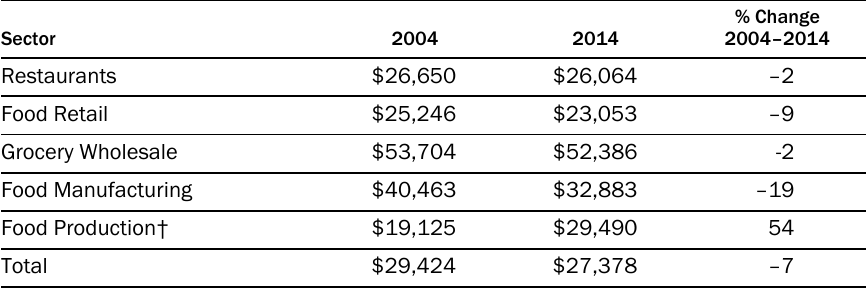
Table 3. Changes in Average Real Annual Wages* in New York City’s Food Sector, 2004–2014